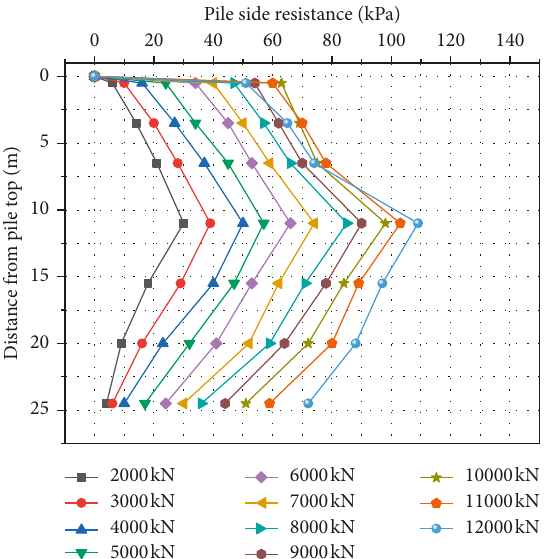
Figure 11: Pile side resistance of MDP.